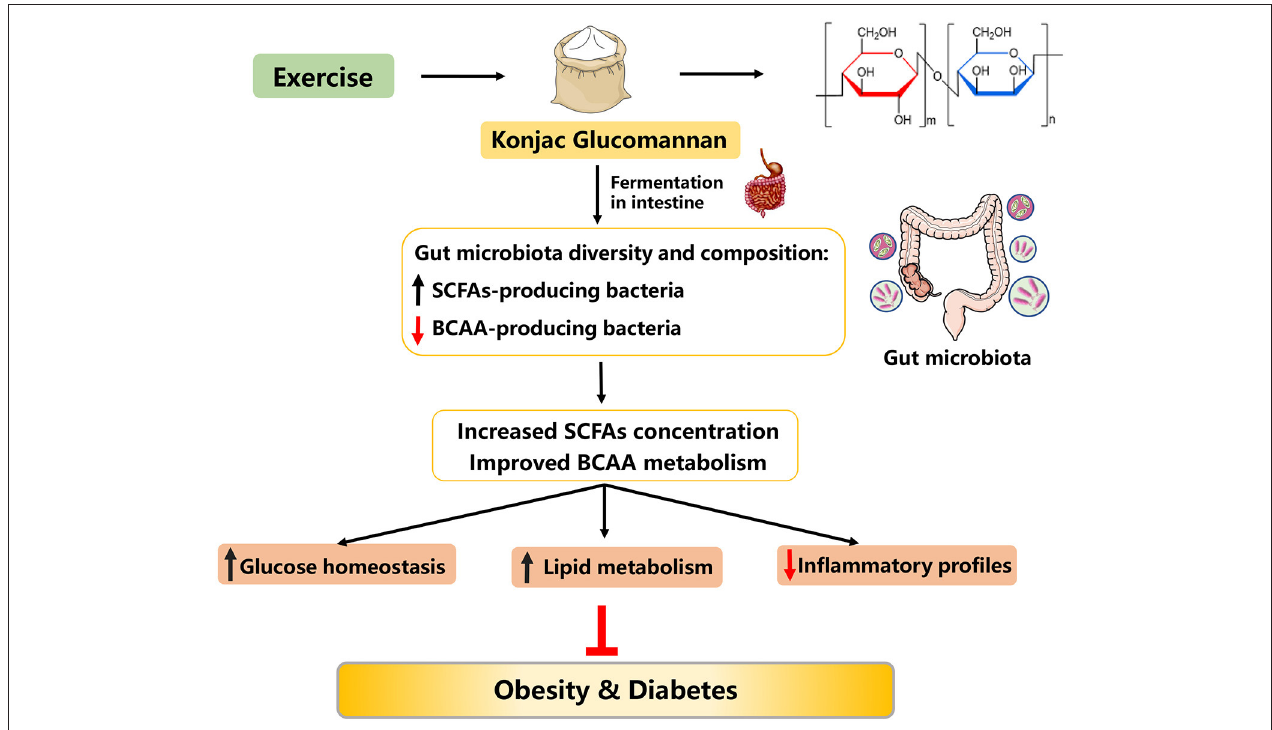
FIGURE 6 | Possible mechanisms explaining the anti-obesity effects of konjac